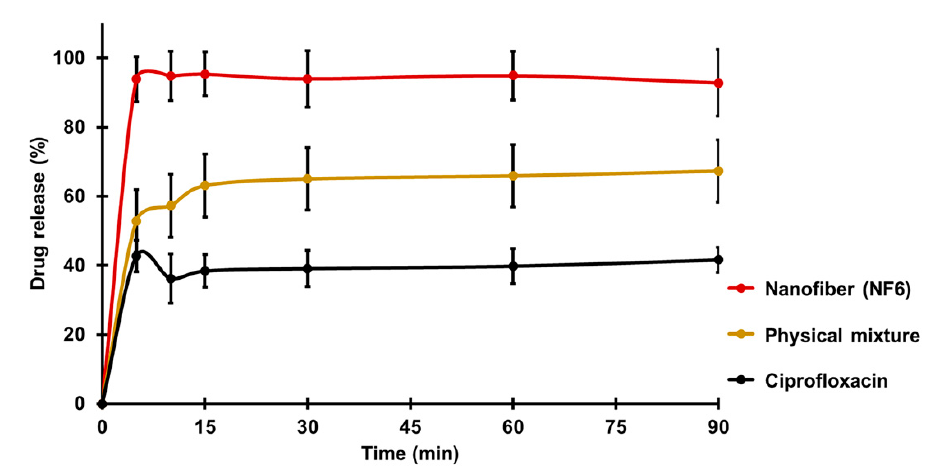
Figure 4. In vitro dissolution of ciprofloxacin (CIP) from NF6 nanofiber, physical mixture, and CIP powder in pH 7.4 phosphate buffer solution. All measured NF6 values were significantly higher than the raw CIP values ( p < 0.001), and the first two were significantly higher than the physical mixture values ( p < 0.05). Statistical analysis: Two-sample t -test.